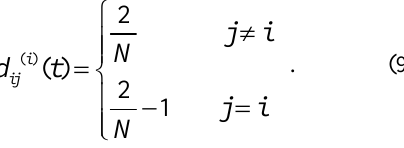
Figure 6 is the flow chart of G-LAR algorithm. In